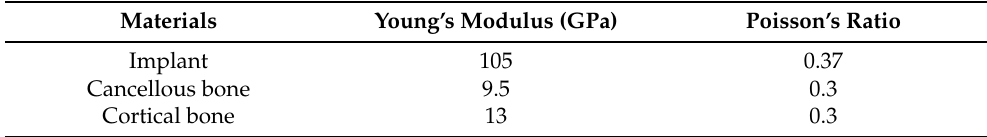
Table 1. Material